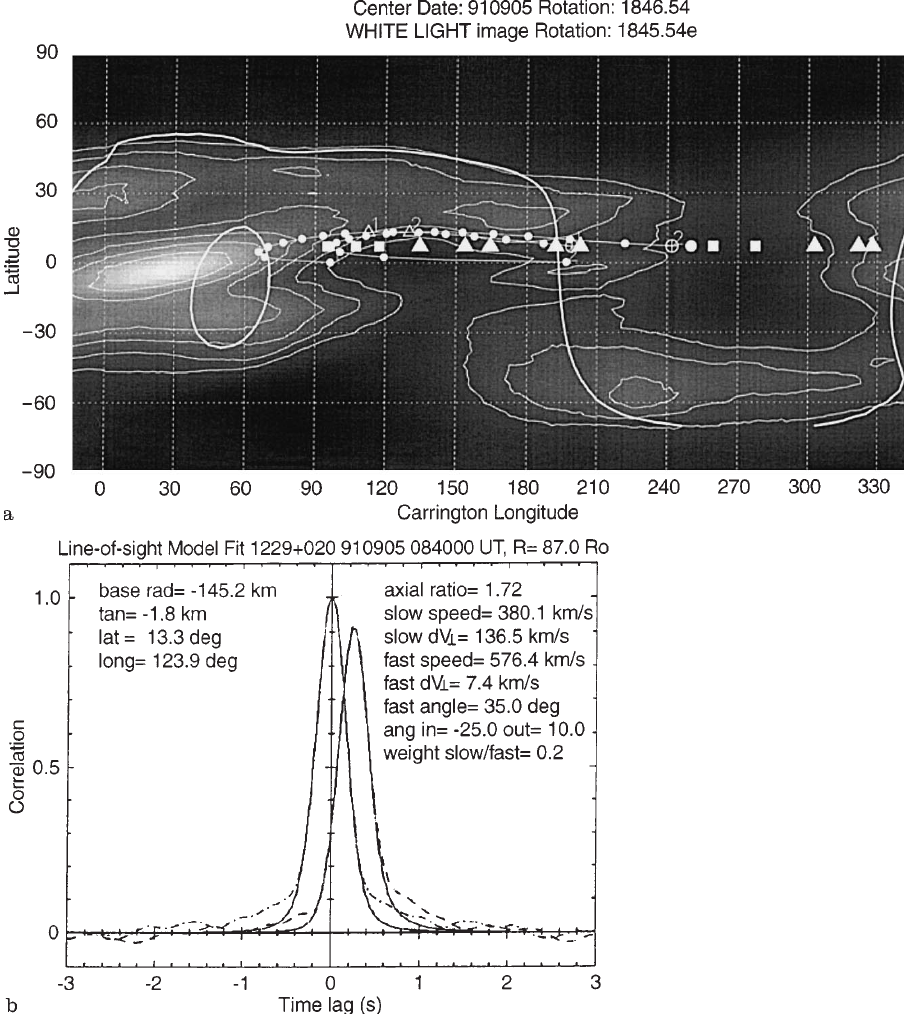
Fig. 8. a White-light map showing the ray-path for an EISCAT observation of 1229+020 on 5 September 1991, projected down to 1.7 R with assumed velocities of 750 km s ) 1 (line 1) and 325 km s ) 1 (line 2). The white line stretching across the whole of the map is the magnetic equator of the Sun, calculated from Stanford magnetic data. The white triangles mark regions of intermediate-velocity flow, measured by the IMP-8 spacecraft at 215 R as the region observed